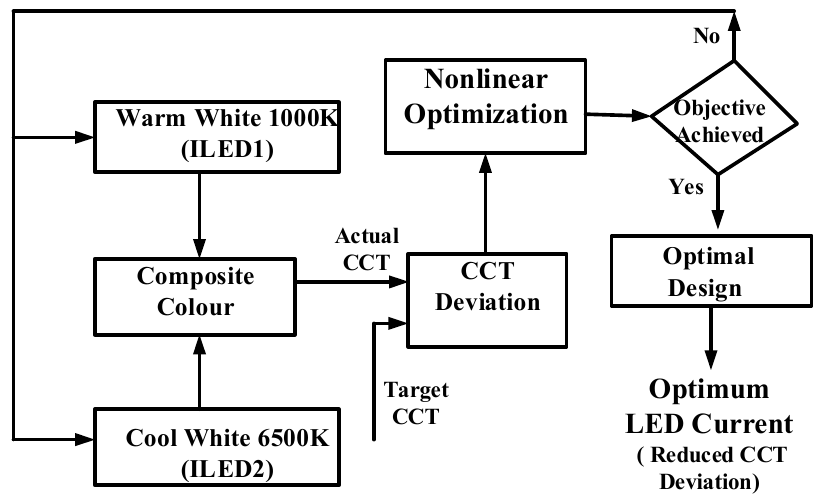
Figure 2. Functional block diagram of the CCT optimization.